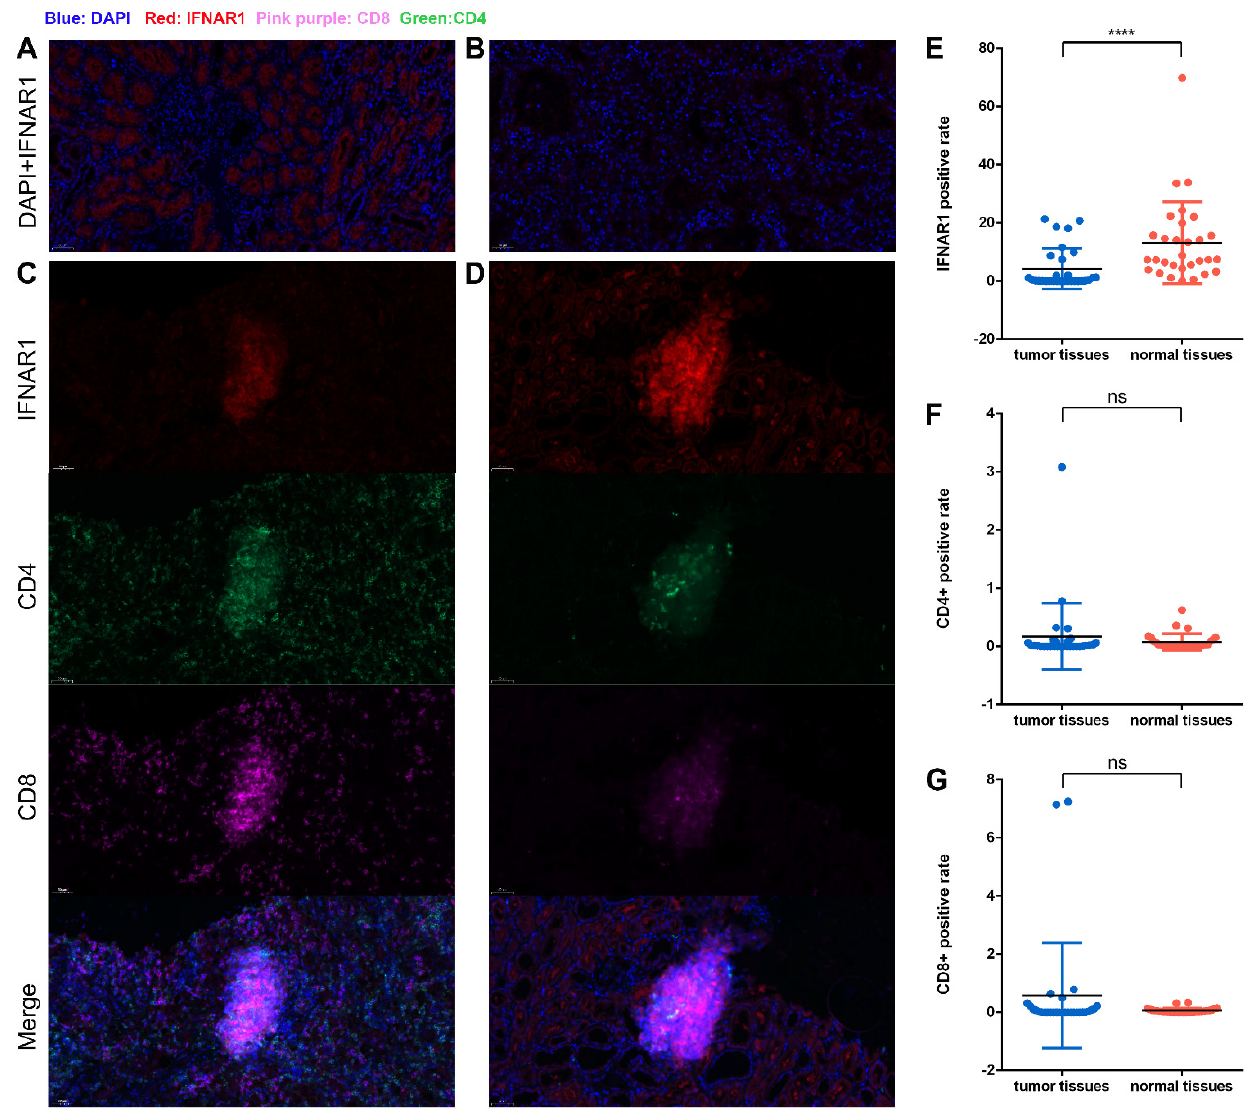
Figure 7. The expression of IFNAR1, CD4 and CD8 molecules in tissues detected by multiplex immunohistochemistry. ( A ) The expression level of IFNAR1 in para-tumor tissues. ( B ) The expression level of IFNAR1 in ccRCC tissues. ( C , D ) The association of IFNAR1 expression level with CD4 and CD8 molecules. ( E – G ) The quantification of IFNAR1, CD4, and CD8 signals (****: p < 0.0001).